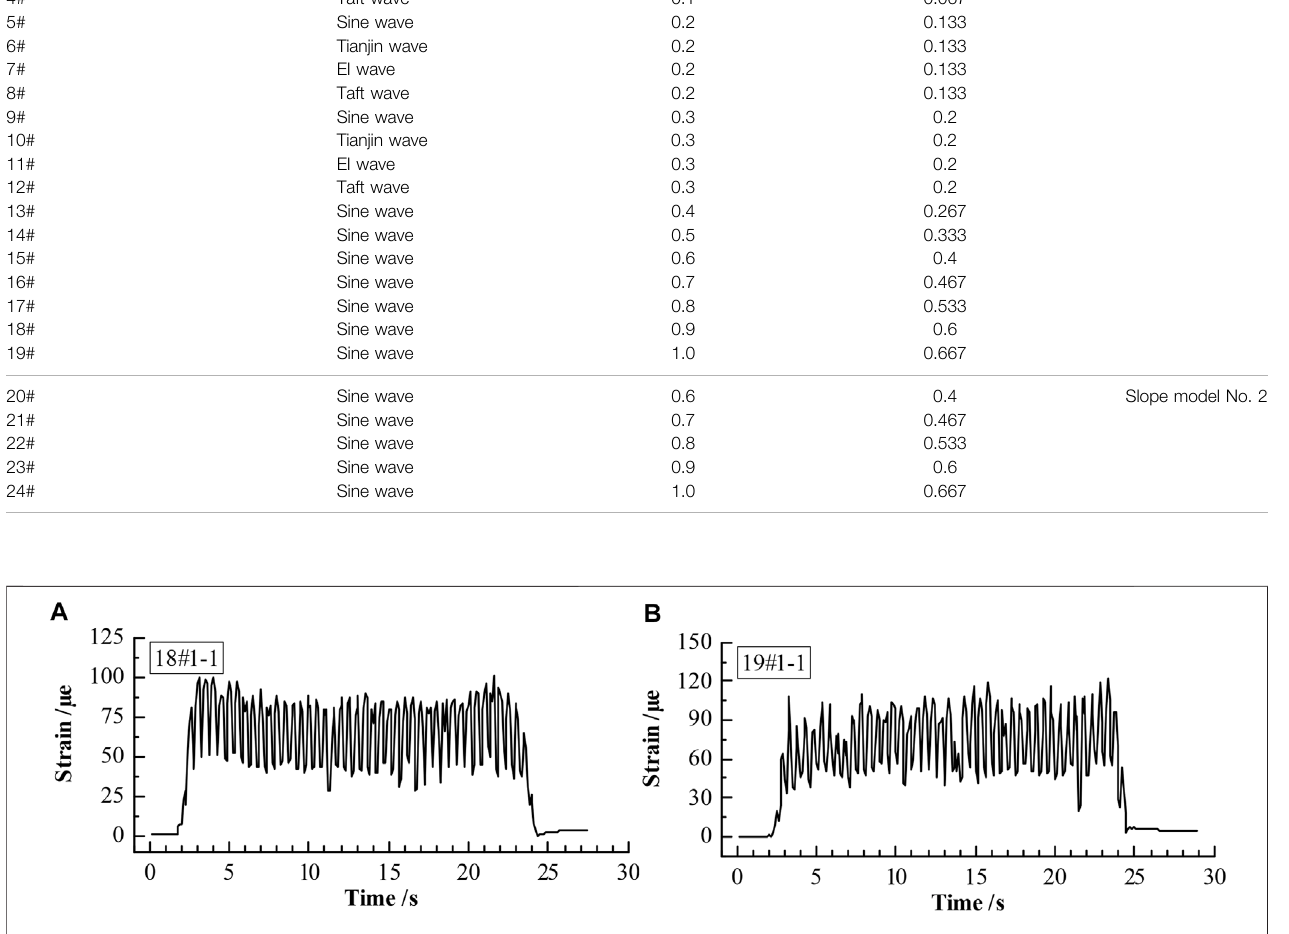
Frontiers in Earth Science |